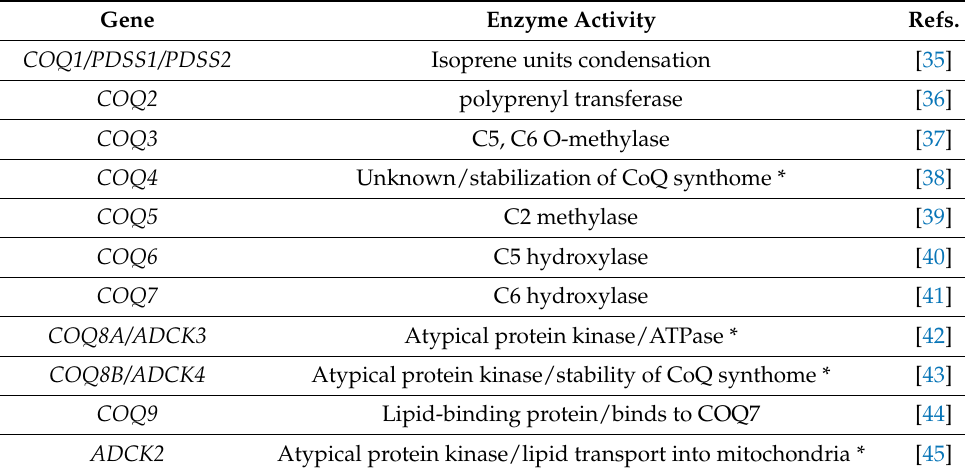
Table 1. Enzyme activities of COQ proteins involved in CoQ